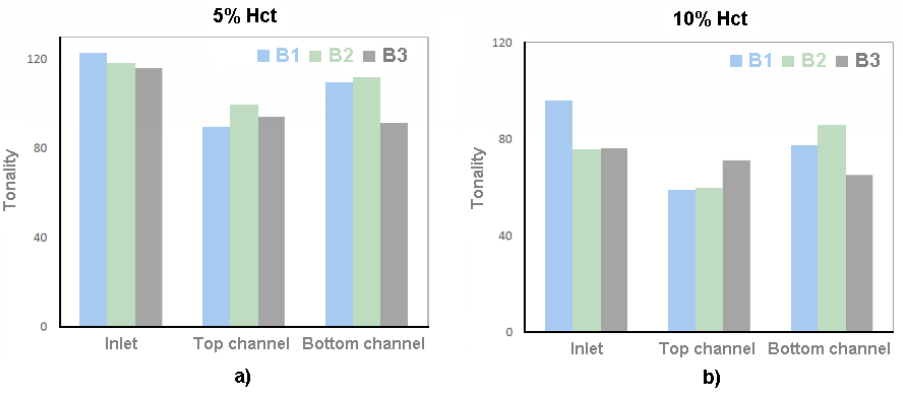
Figure 11. Tonality for ( a ) case 1, 5% Hct, and ( b ) case 2, 10% Hct.